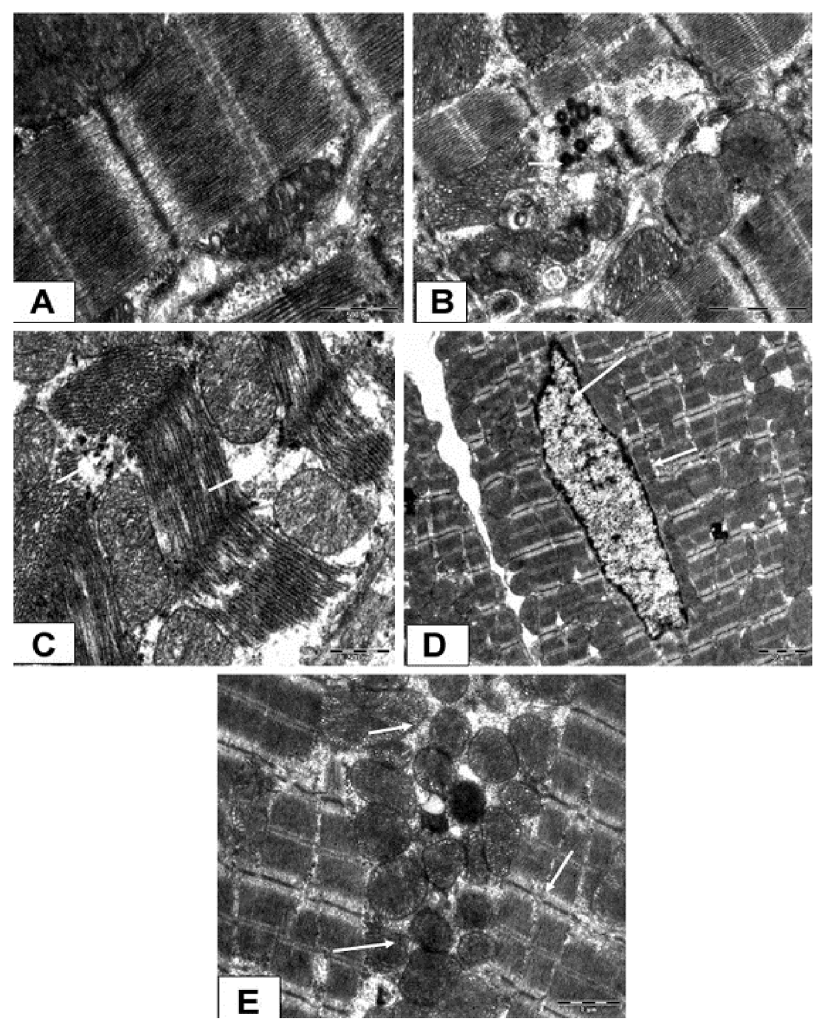
Figure 4. Photomicrograph showing the ultrastructural changes in the rat myocardium. (A) represents transmission electron microscope [(TEM) 6 4800] in diabetic sham group, B diabetic ischaemia/reperfusion (I/R) group (TEM 6 3500), (C) diabetic I/R + hesperidin treatment (100 mg/kg) (TEM 6 3500), (D) diabetic I/R + GW9662 (1 mg/kg) (TEM 6 3500) and (E) diabetic I/R rats + GW9662 + hesperidin (TEM 6 3500).